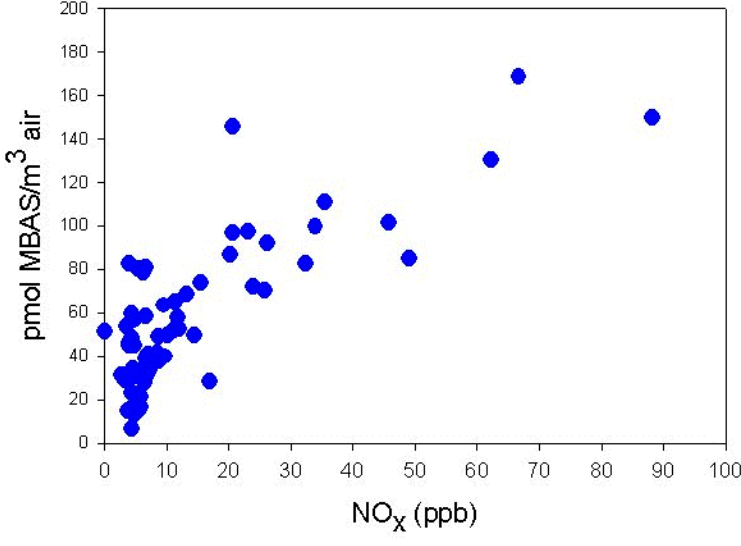
FIGURE 4. The MBAS concentration in the atmosphere as a function of NO x